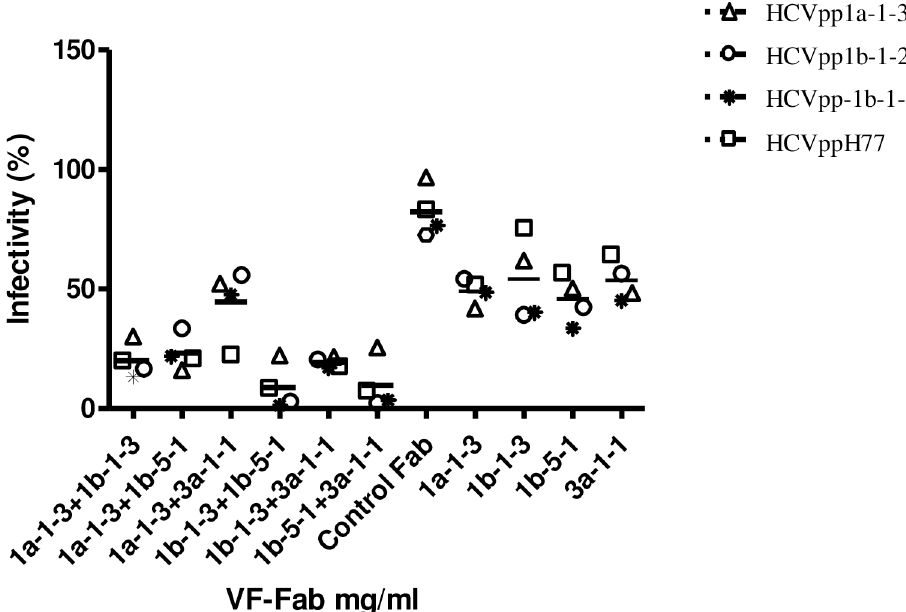
Fig 6. Neutralisation of pseudotyped virus with combination of VF-Fabs. HCVpp1a-1-3, HCVpp1b-1-2, HCVpp1b-1-3 and control HCVppH77 were tested for neutralisationusing the averageLog IC 50 (mg/ml) for the VF-Fab in combinations (Table 5). The data is obtainedfrom three independentexperiments. Data for all the HCVpp were groupedtogether for statistical analysis. Significance was tested using one-wayANOVA with Dunnett t test (p < 0.05–0.001, Table 5). Each VF-Fab combination was comparedagainstindividualVF-Fab at the concentration used in combination experiments.